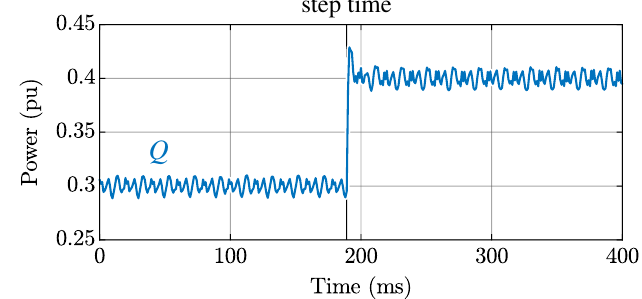
Figure 13. Reactive power step response. This highlights the capability of injecting or absorbing reactive power and therefore contributing to the regulation of the